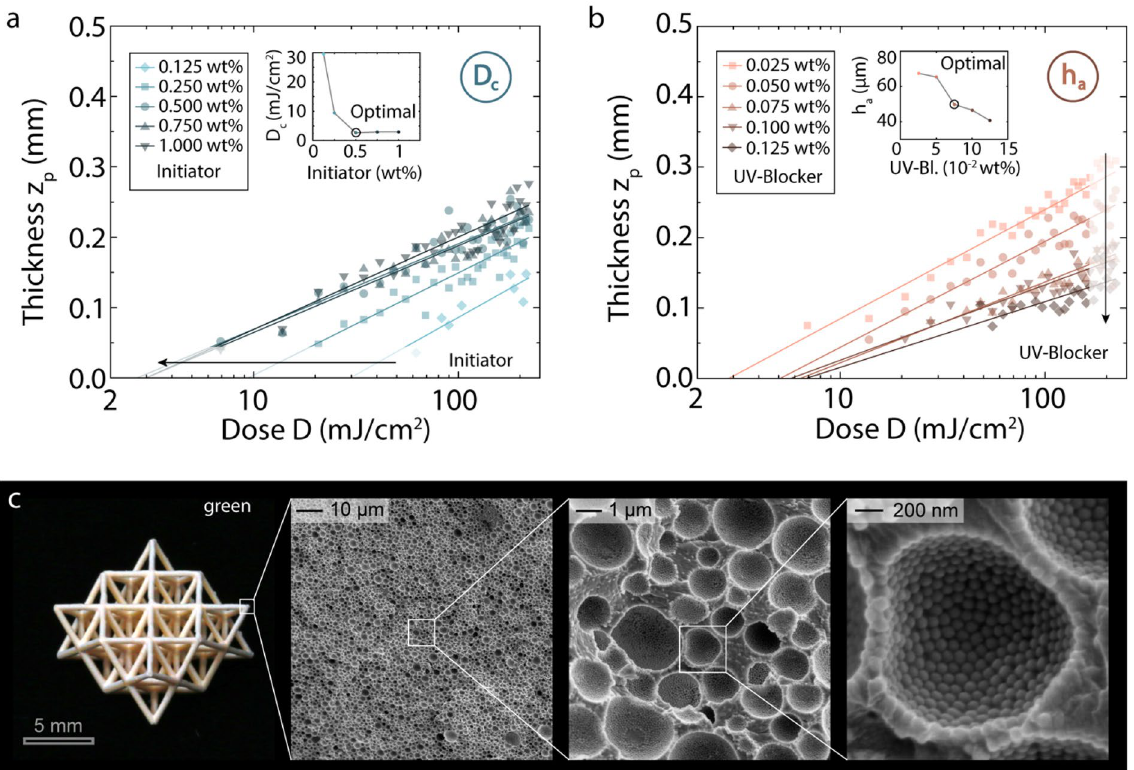
Figure 2. Photo-polymerization behaviour of photo-curable emulsions and DLP printing of hierarchical lattices. ( a , b ) The effect of the light dose ( D ) on the thickness of the photo-polymerized layer ( z p ) for emulsions containing ( a ) initiator concentrations between 0.125 and 1 wt% (0.075 wt% UV blocker) with respect to the monomer, or ( b ) UV blocker contents varying from 0.025 to 0.125 wt% (0.5 wt% initiator) with respect to the monomer. The dependence of the critical dose (D c ) and of the penetration depth (h a ) on the concentration of initiator and UV blocker, respectively, is shown in the insets. ( c ) Hierarchical octet lattice prepared by DLP printing of an optimum emulsion formulation using a light intensity of 20 mW/cm 2 for 3 s per polymerization layer. The photograph reveals the open cells at the macroscale, whereas SEM images illustrate the microstructure of the lattice struts at different